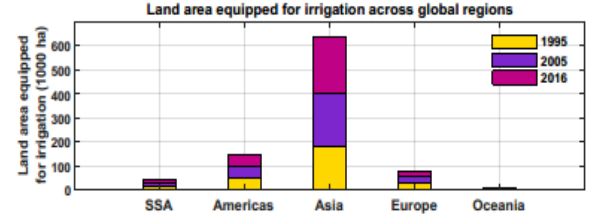
Figure 13. Total land area equipped for irrigation across global regions 1995 – 2016